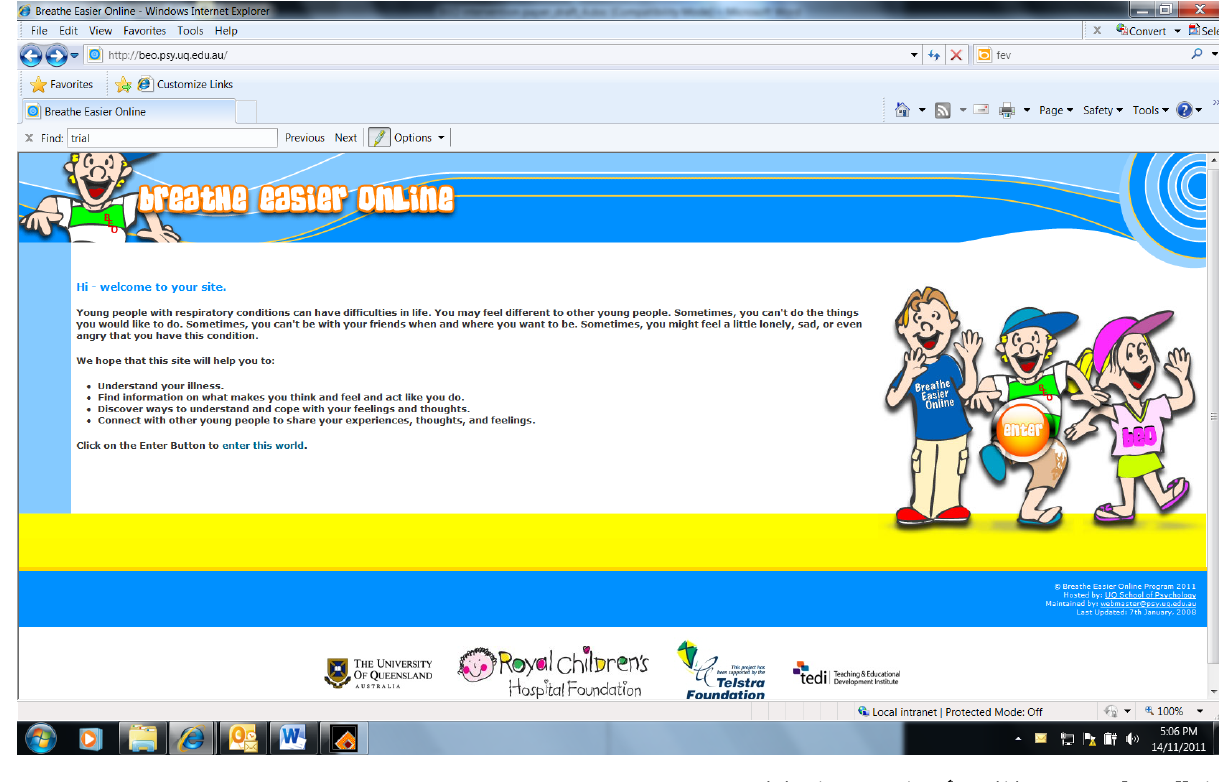
Figure 1. Screenshot of Breathe Easier Online home